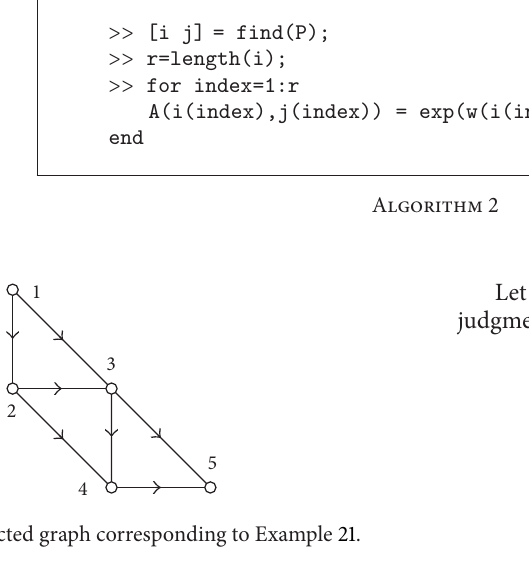
Figure 3: Directed graph corresponding to Example